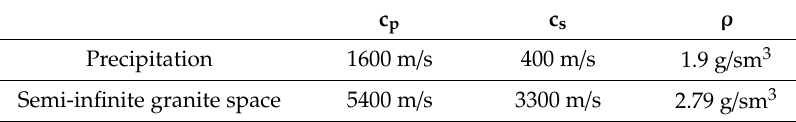
Figure 6. Solution domain. Table 3. Medium parameters used for the simulation.